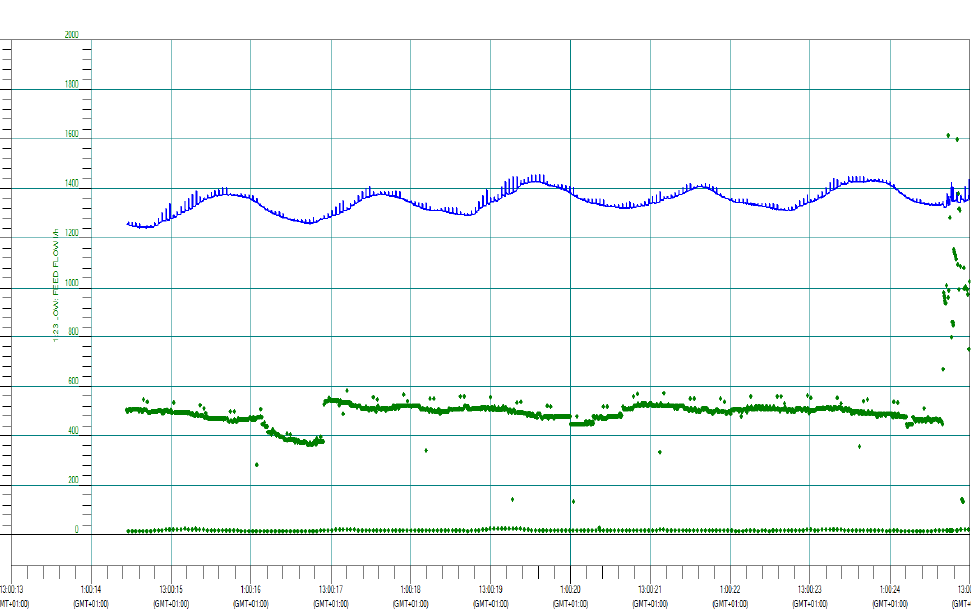
Figure A3. Flow and permeate turbidity (low resolution).